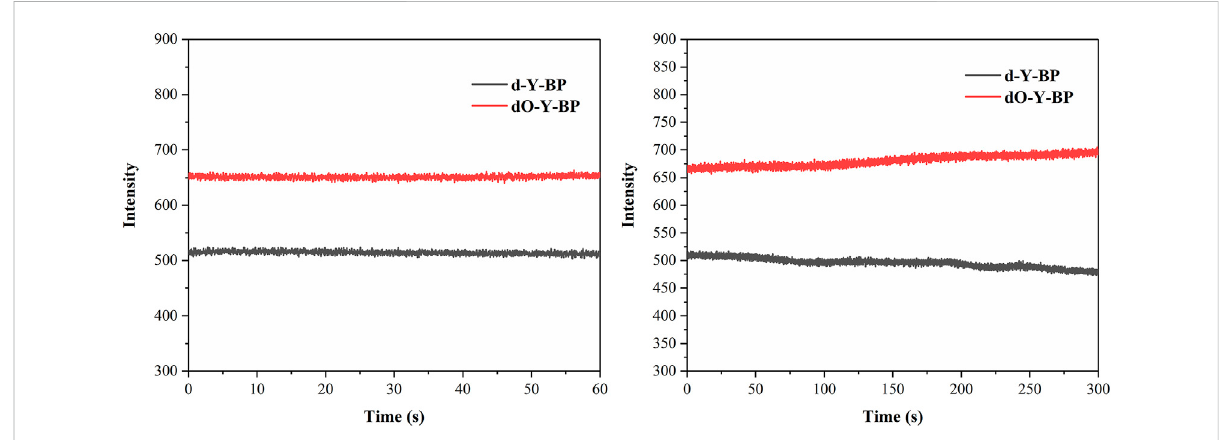
FIGURE 2 Fluorescence stability of d/dO-Y-BP .